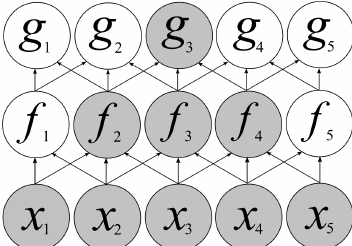
Figure 6. Description of sparse interactions. Even if direct connections seem to be sparse, more units at deeper layers are indirectly